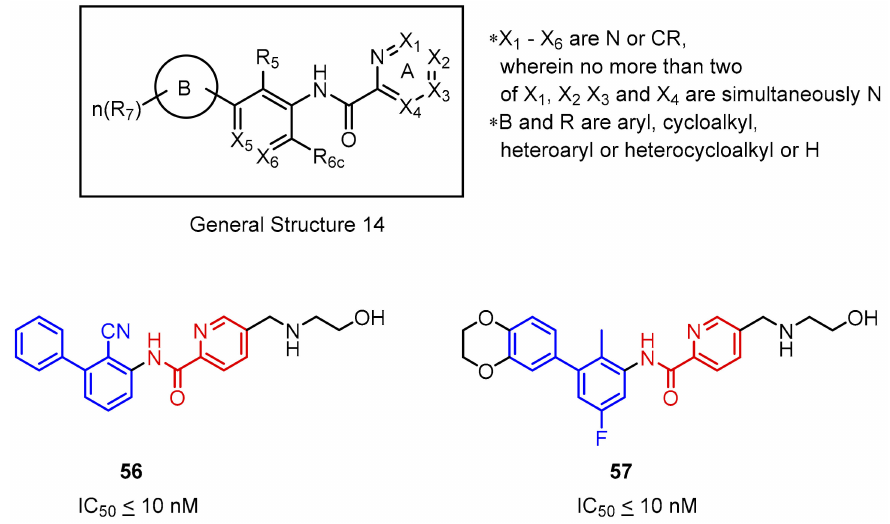
Figure 24. General structure and examples of the PD-1 / PD-L1 inhibitors ( 56 and 57 ) reported by Incyte Corporation, based on the picolinamide-biphenyl sca ff